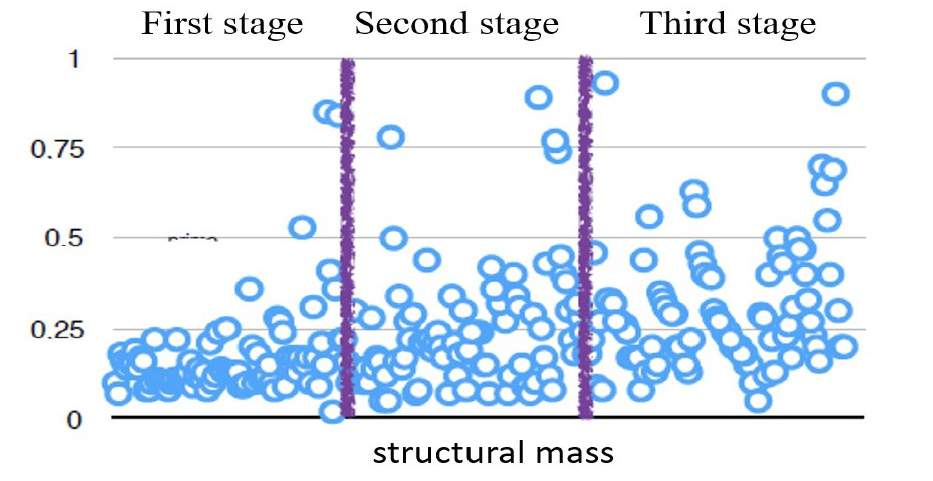
Figure 3. The structural mass ratio of different stages taken from the database ©Mark Wade